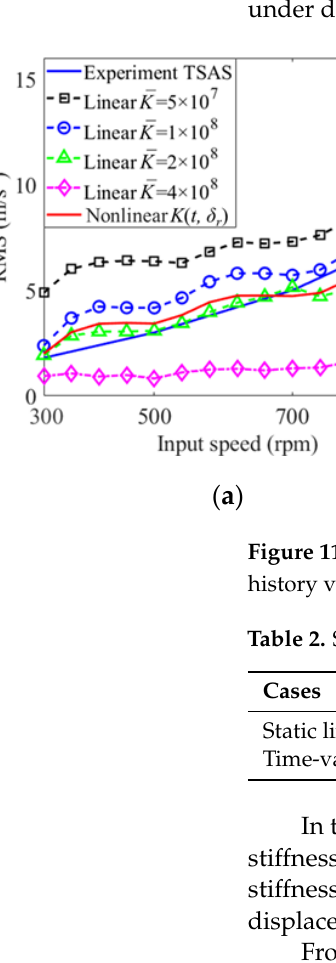
( b ) Figure 12. Dynamic responses of sun gear with 700 rpm-200 N  m: ( a ) experimental data and its time- synchronous average signal; ( b ) experimental data and simulation data (note: TSAS means the Time-Synchronous Average Signal). Figure 13 shows the results of Figure 12b in the logarithm frequency domain. Herein, f m denotes the mesh frequency of the PGS. In Figure 13, the frequency spectrum of the measured signals is plotted by the solid line, and the frequency spectrums with or without time-varying nonlinear support stiffness are plotted by the dashed line and dotted line, respectively. The simulation results have fewer spectral lines, which may be caused by the existence of small eccentricity errors of planet gears and ring gears, and other manu- facturing errors.